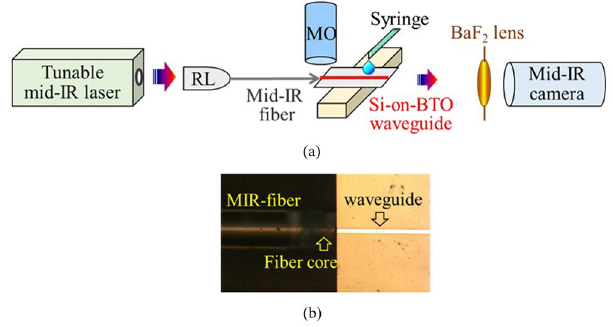
Figure 6. ( a ) Mid-IR test station to characterize the performance of our Si-on-BTO waveguide sensor. The probe light from a tunable pulsed laser ( λ = 2.4 μ m to 3.8 μ m) was collimated into a mid-IR fiber using a reflective lens (RL) and then butt coupled into the waveguide. Meanwhile, the analytes was dropped onto the waveguide surface through a syringe. The mid-IR light emitted from the waveguide end facet were focused by a barium fluoride biconvex lens and then imaged by an InSb camera. ( b ) The core of the mid-IR fiber was lined up with the front facet of the Si waveguide. The fine alignment between the optical fiber and the waveguide was monitored by an upper microscope